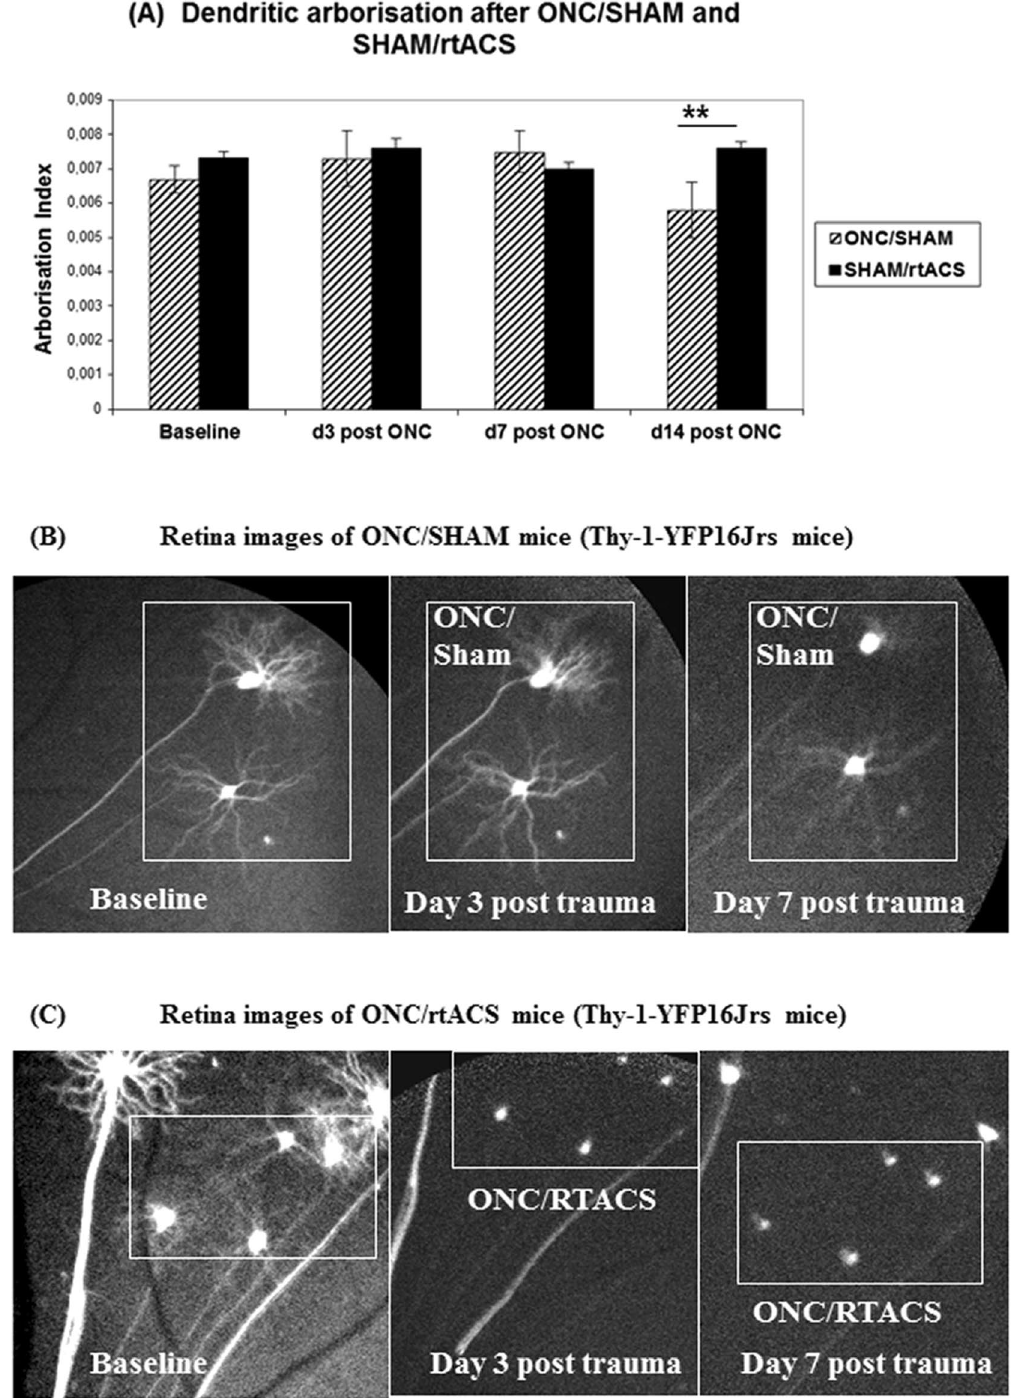
Figure 5. Influence of axonal trauma and rtACS on dendritic morphology. In ( A ) the bar graphs representing the dendritic tree arborisation index demonstrate the dendritic regression in the ONC/SHAM group at 2 weeks after ONC as compared to non-lesioned controls (SHAM/rtACS). Also of note is that no data could be collected from the lesioned, rtACS stimulated animals as no dendrites were visible after ONC in the ONC/rtACS group. ( B ) and ( C ) illustrate the differences in dendritic arborisation after ONC depending on the treatment schedule. Whereas RGCs with SHAM stimulation exhibit a clearly visible dendritic tree early after ONC (Fig. 5B), in the ONC/rtACS group only the soma without any dendrites was detectable even at the earliest time point of imaging (3 post ONC; ( C